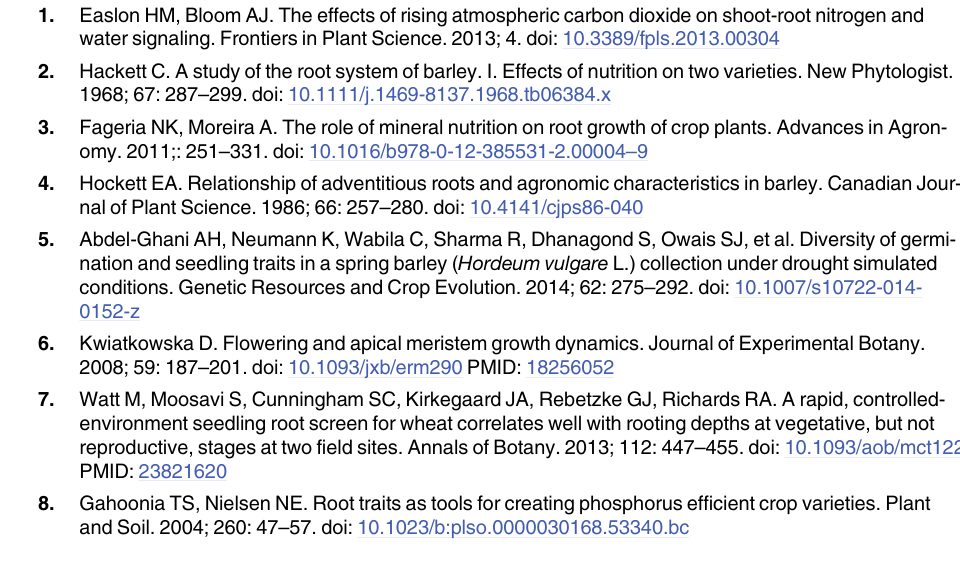
Figure C, Genetic interaction plot of Vrn-H1 and Vrn-H3 alleles for RV (root volume). All nine possible allele combinations of both genes are plotted using R-interaction plot. Figure D, Genetic interaction plot of Vrn-H2 and Vrn-H3 alleles for RV (root volume). All nine possible allele combinations of both genes are plotted using R-interaction plot. Figure E, Genetic inter- action plot of Vrn-H2 and Vrn-H3 alleles for RL (root length). All nine possible allele combina- tions of both genes are plotted using R-interaction plot. Figure F, Genetic interaction plot of Vrn-H2 and Vrn-H3 alleles for TIL (no. of tillers). All nine possible allele combinations of both genes are plotted using R-interaction plot. Table A, List of primers used for the genotyping and sequencing of the candidate genes. Forward (F) and reverse orientation (R) primers. Table B, Barley haplotype scoring from five non-synonymous SNPs and one SSR (simple sequence repeat) in the exon1 and exon 2 of ZCCT-Ha gene. Table C, Barley haplotype scoring from six non synonymous SNPs in the exon1 and exon 2 of ZCCT-Hb gene. Table D, Barley haplotype scoring from two described SNPs in the exon8 of PPDH1 gene. Table E, Barley haplotype scor- ing from two SNPs in the intron 3 of PPDH2 gene. Table F, Barley haplotype scoring from nine SNPs and three indels in the exon 2 and intron 2 of HvELF3 gene. Text A, Description of HvCCA1 , HvLUX1 and HvCEN alleles in cultivar Cheri and ICB181160.